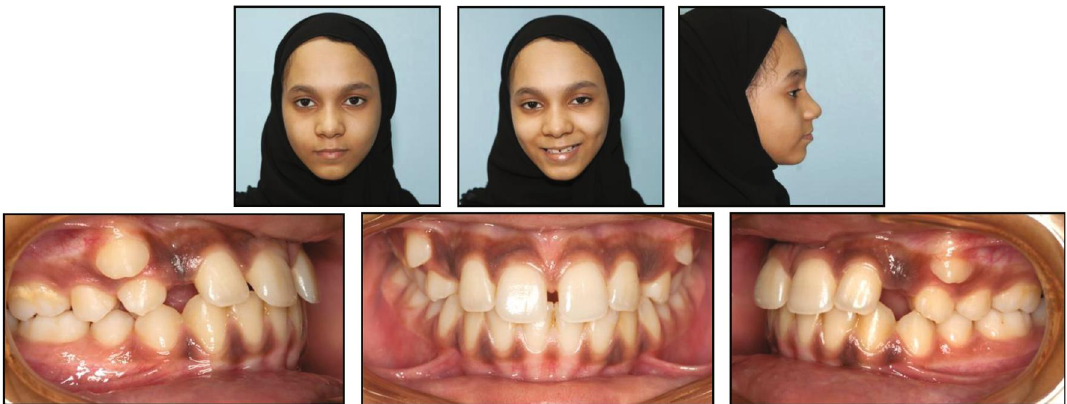
Figure 1: Pretreatment facial and intraoral